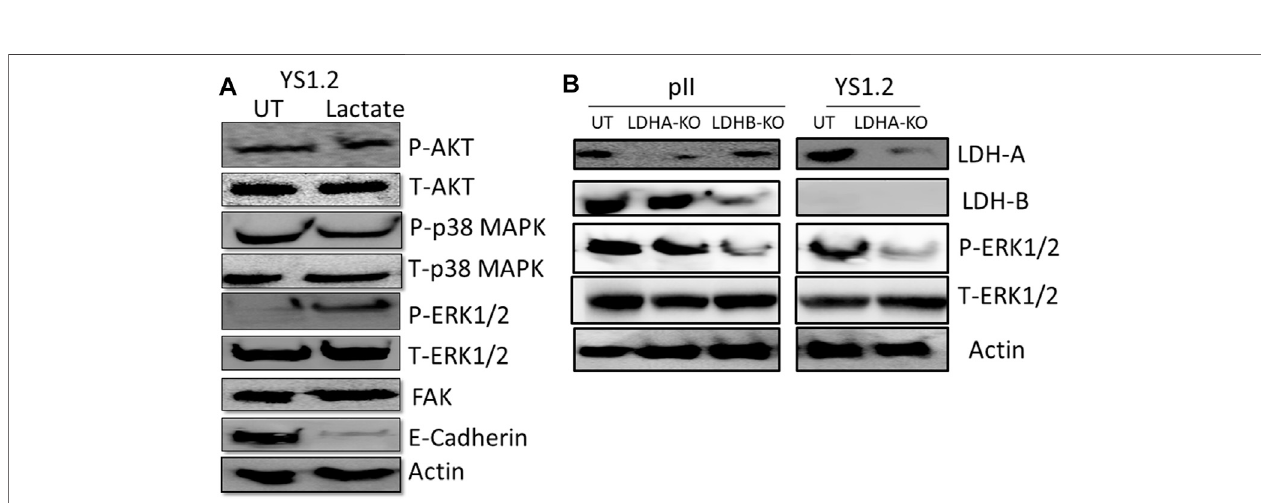
FIGURE6| Effect oflactate supplementationor LDH isoenzyme knockdown ontheexpression/activity ofsignaling molecules. (A) showswesternblotting analysis of P-AKT, P-p38 MAPK,P-and T-ERK1/2, FAK, E-cadherin, and actin (loading control) in YS1.2 either untreated (UT), or cells treated withlactate(20 mM for 24 h). The blot represents one out of three similar experiments. (B) shows western blotting analysis of LDH-A, LDH-B, P-ERK 1/2, and actin (loading control) in pII or YS1.2 cells, either untreated (UT) or treated with LDH-A or -B lentivirus. The blot represents one out of three similar experiments.